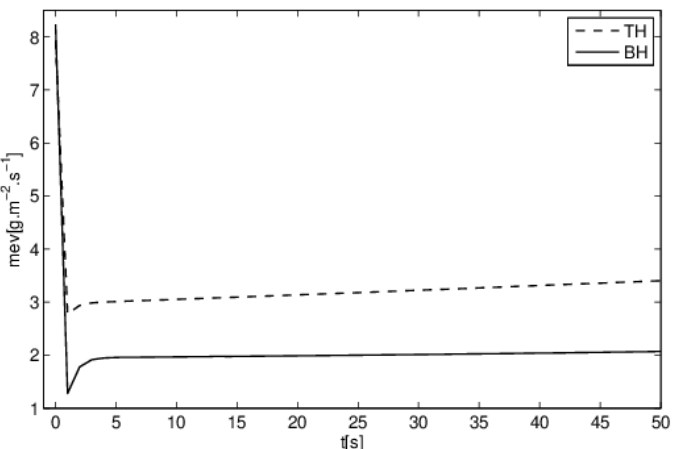
Figure 9. Average flux rate evolution vs time for two configurations. (t = 1s,  = 90°, V 0 = 1 mm 3, T h = 50 °C, Φ = 40 mW). T h = 50 ◦ C, Φ = 40 mW).